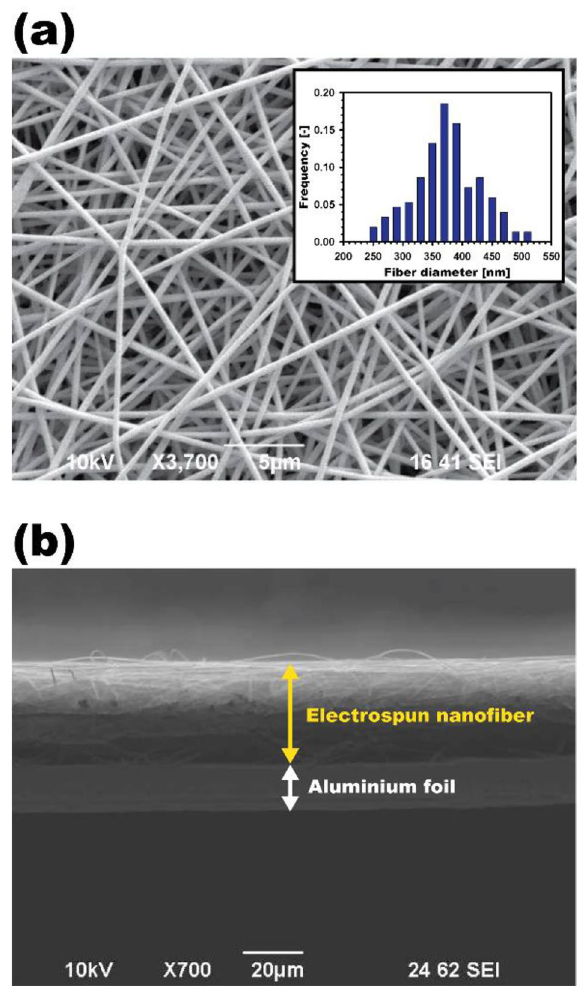
Figure 4. SEM images of 8 wt% PAN electrospun nanofiber: ( a ) front view for the fiber size measurement (embedded figure: fiber size distribution of nanofibers); ( b ) side view for the thickness measurement.